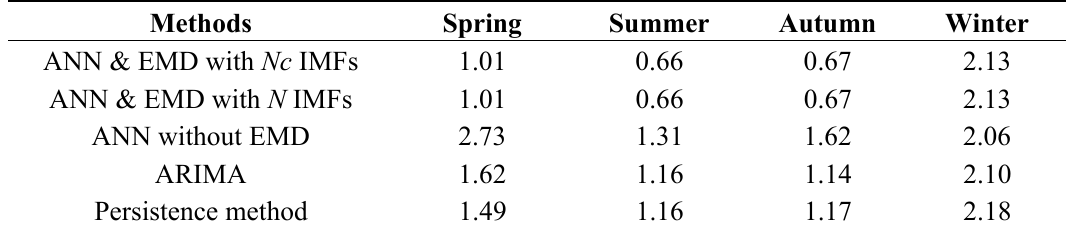
Table 6. RMSE of forecasted wind speed (m/s) obtained by various methods.